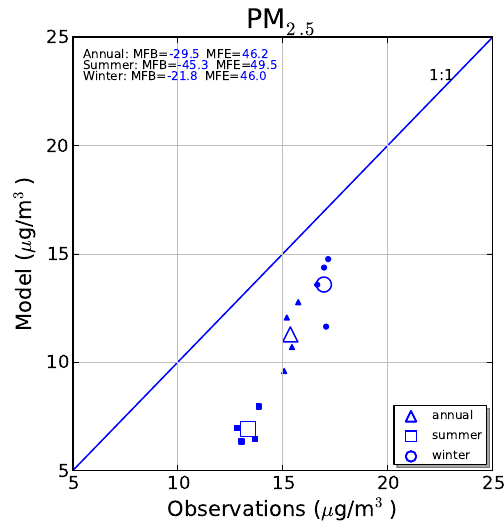
Figure 3. Scatter plot of mean daily PM 2 . 5 from the model run dur- ing summer (JJA), winter (DJF) and on annual basis against obser- vations. Small solid markers represent concentrations at individual stations while large hollow markers stand for the aggregated